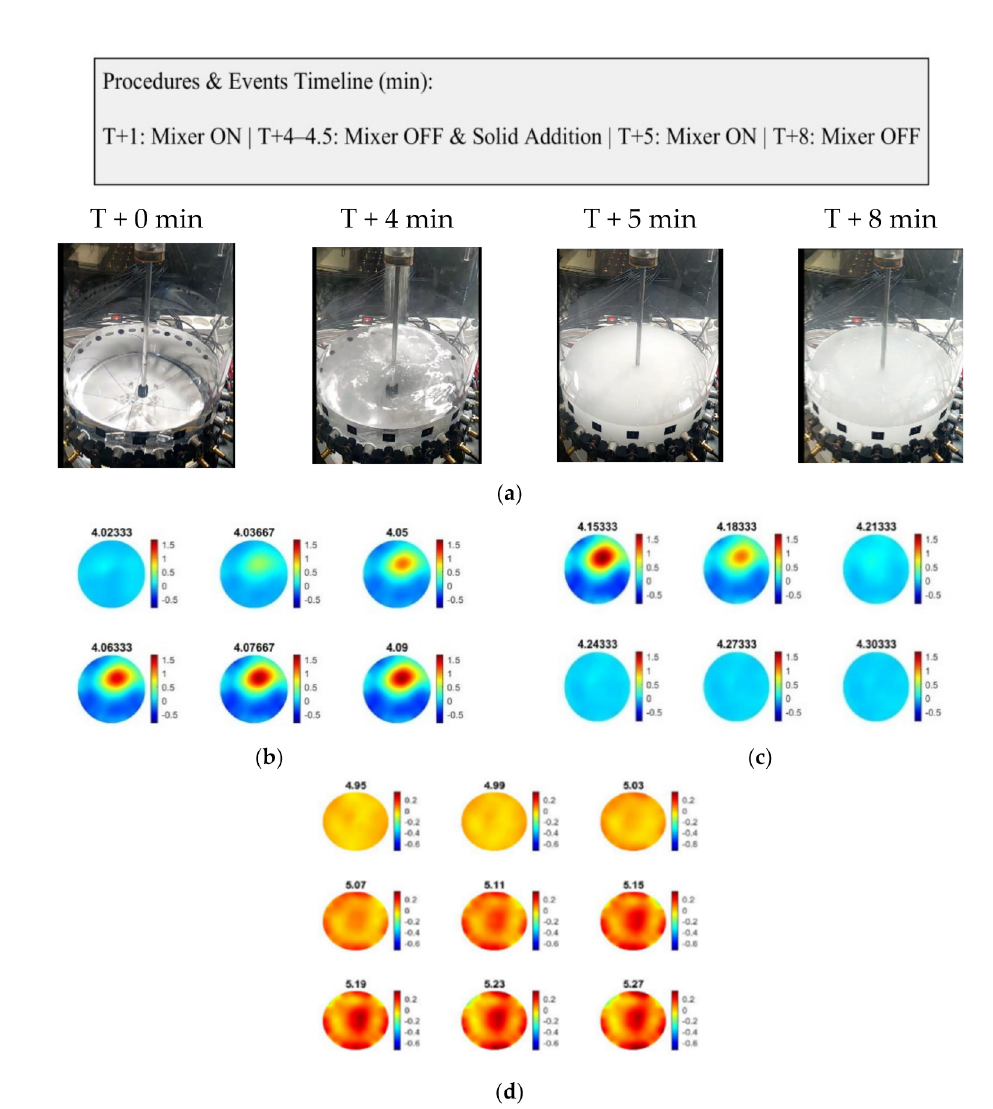
Figure 8. ( a ) Images on shown time step images of feeding. ( b , c ) Reconstruction between times 4.02 min and 4.30 min, describing feeding. ( d ) Reconstruction between times 4.95 min and 7.43 min during the mixing